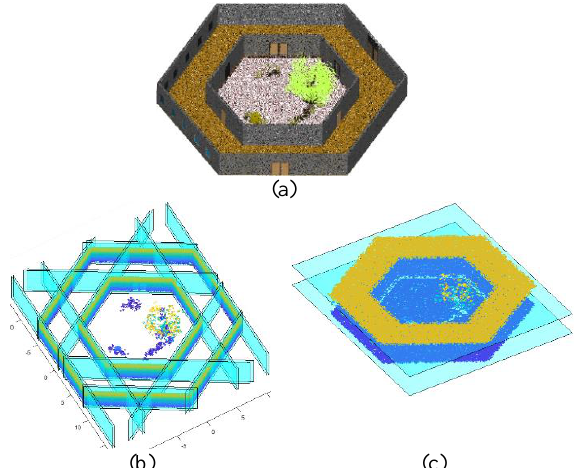
Fig. 4. Extraction of potential building structures of the synthetic building: (a) synthetic point cloud (the ceiling is removed for better visualization), (b) vertical structures, i.e., walls, (c) horizontal structures, i.e., the ceiling and the floor.